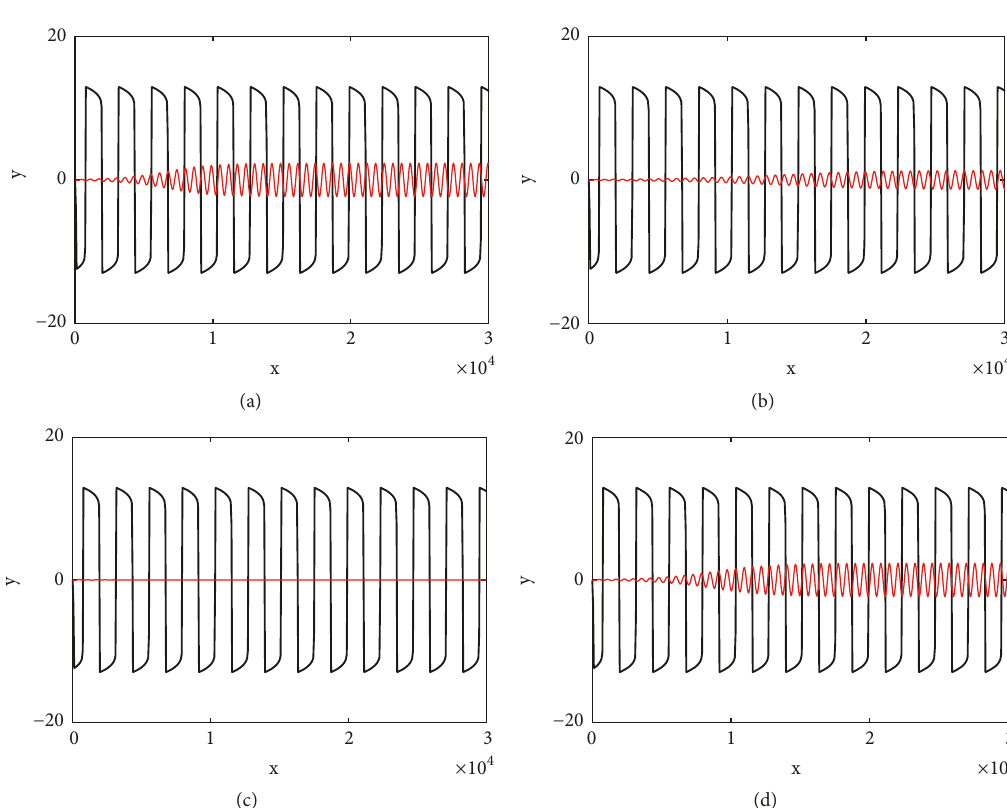
Figure 7: Time series corresponding to Figure 4(b). (a) 𝜏 = 0.2 , birhythmic oscillators; (b) 𝜏 = 1.16 , birhythmic oscillators; (c) 𝜏 = 3.0 , the bistable behaviors with coexistence of a stable LC and SSS; (d) 𝜏 = 6.0 , birhythmic oscillators. The red line is for initial conditions 𝑥 = 0.1, ̇𝑥 = 0, V = 0.3 and the black line is for the initial conditions 𝑥 = 7.0, ̇𝑥 = 0, V = 0.3